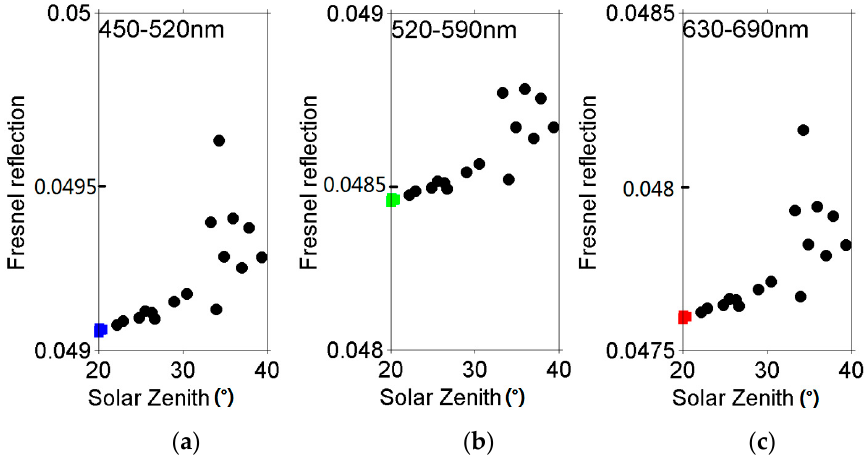
Figure 8. Fresnel reflection coefficients of 22 samples: ( a ) 450–520 nm; ( b ) 520–590 nm; ( c ) 630–690 nm (colored squares represent samples with solar zenith angles between 19 and 22°).